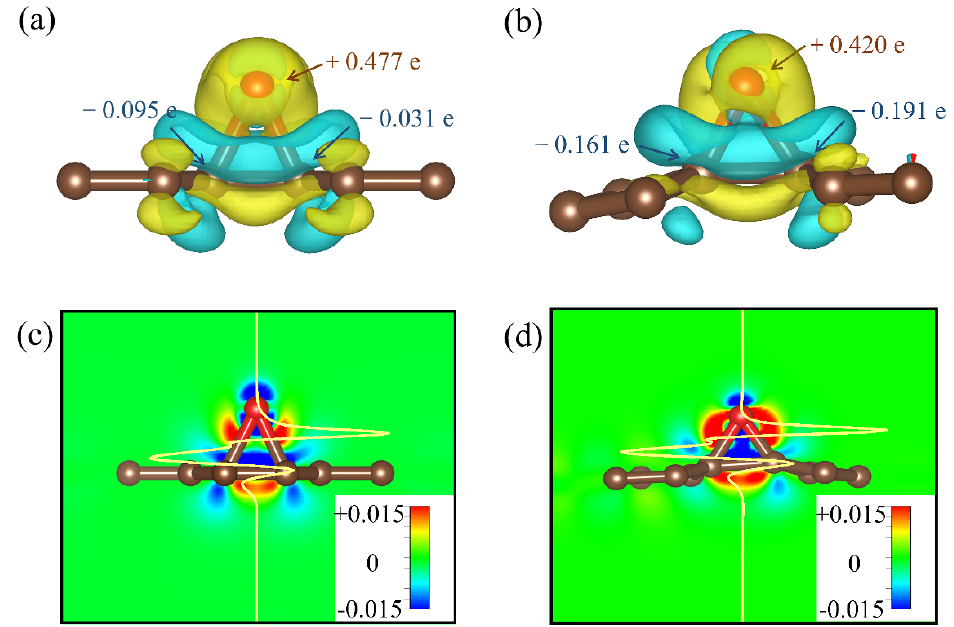
Figure 4. Side view of discrepancies in the charge density of O adsorption on different sites. Charge density of the lowest energy adsorption configuration for O adsorption: ( a ) two C 2 , ( b ) C 1 , and C 2 . Interfacial charge transfer for O adsorption: ( c ) two C 2 and ( d ) C 1 and C 2 . Table 1. The charge transfer of the atoms of biphenylene while O atom adsorbing at B 1 site. C i /O